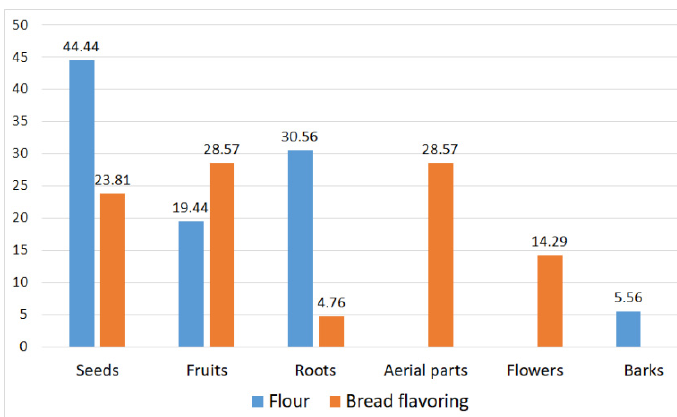
Figure 6. Parts used for the production of flour and bread flavoring of 53 alimurgic taxa present in the AlimurgITA